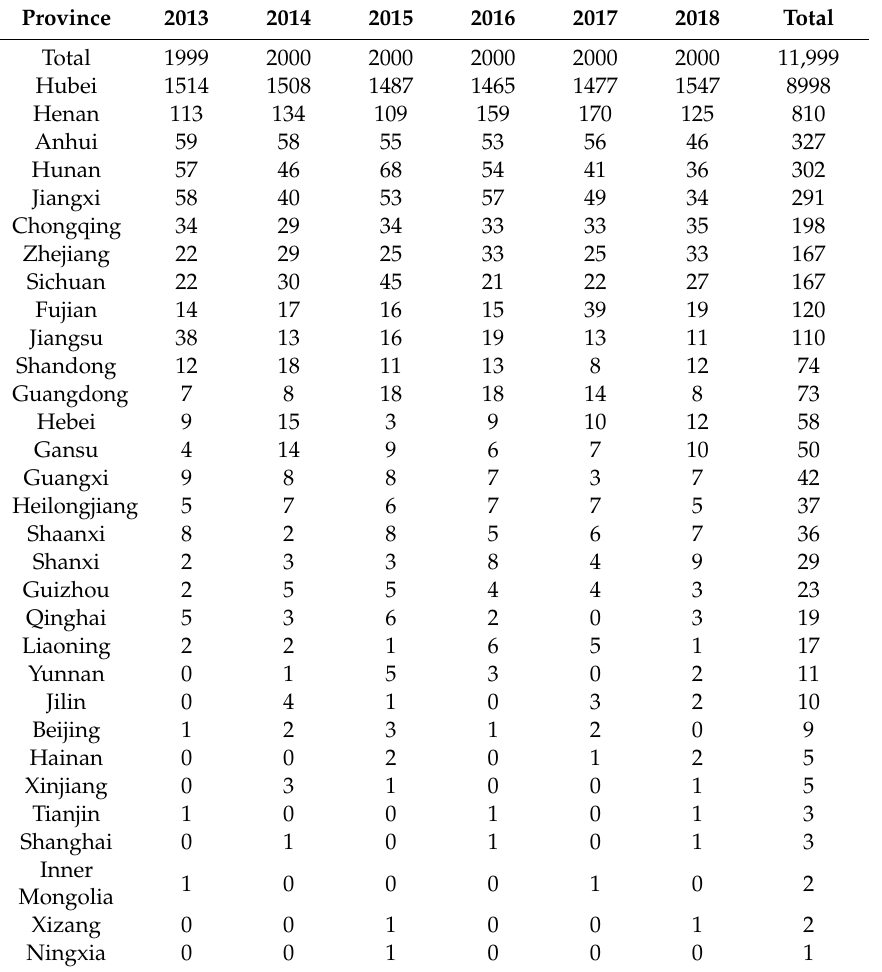
Table 2. Household registration distribution of floating population in Wuhan,